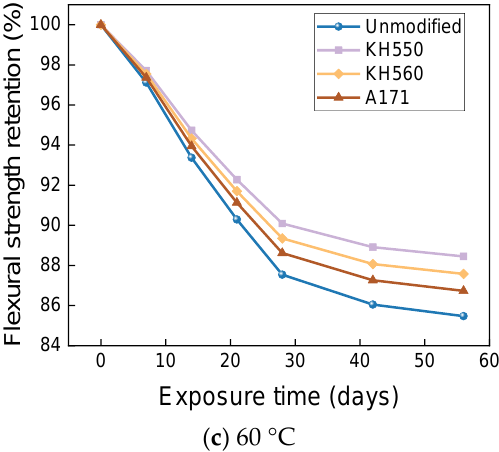
Figure 18. Flexural strength retention in a water environment.